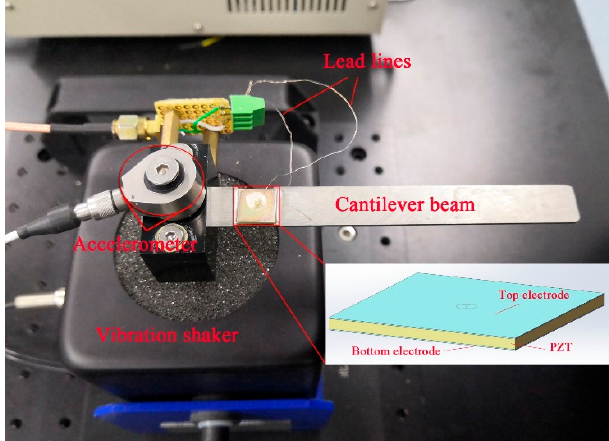
Figure 5. The experimental equipment of the piezoelectric energy harvester.